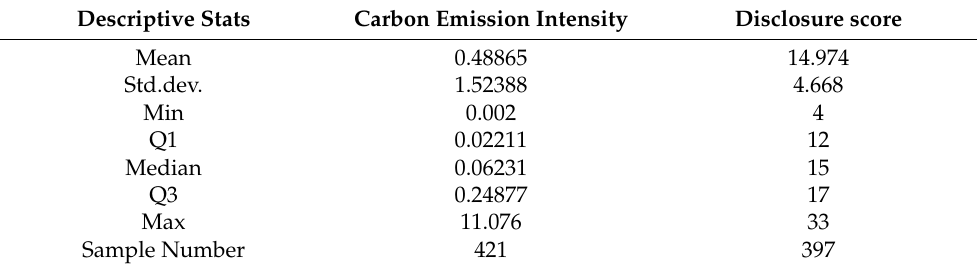
Table 3. Summary of Company Carbon profile.